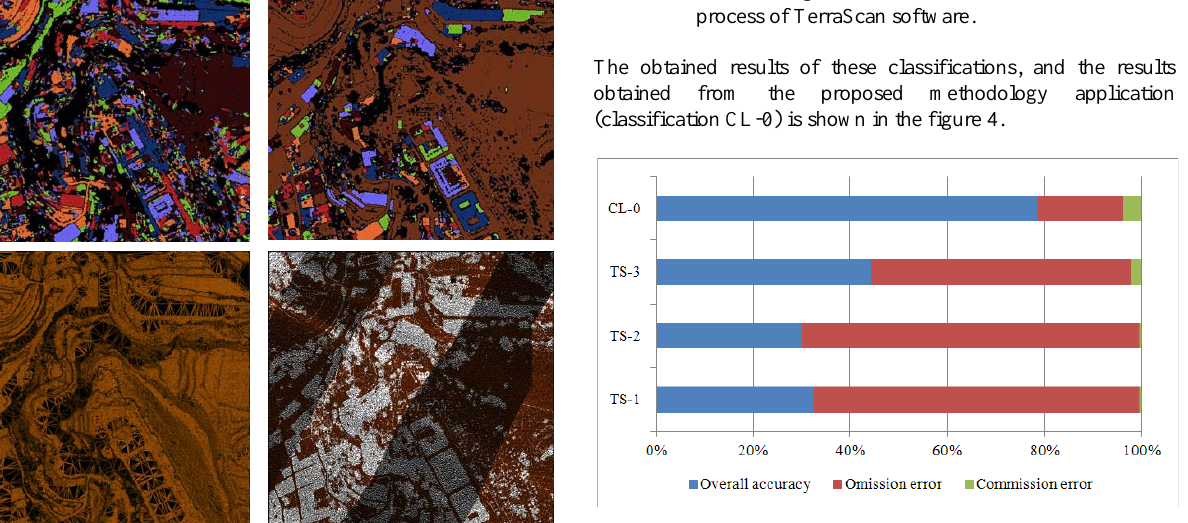
Figure 4. Obtained results in the data classification for the different